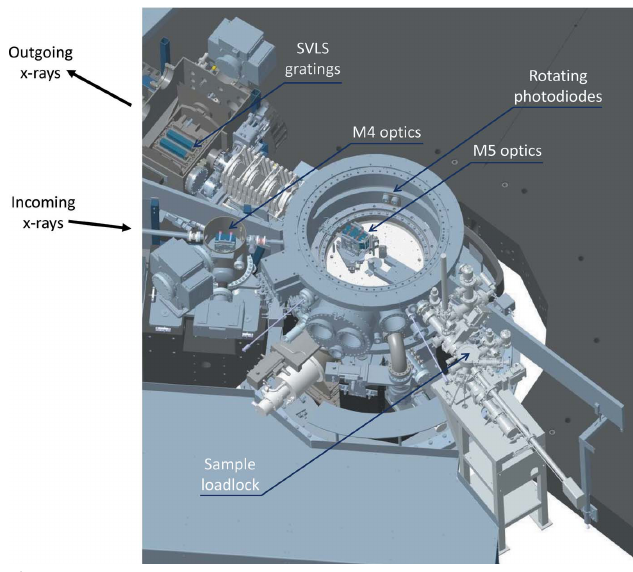
Figure 12 A rendering of the I21 sample station and the surrounding area.